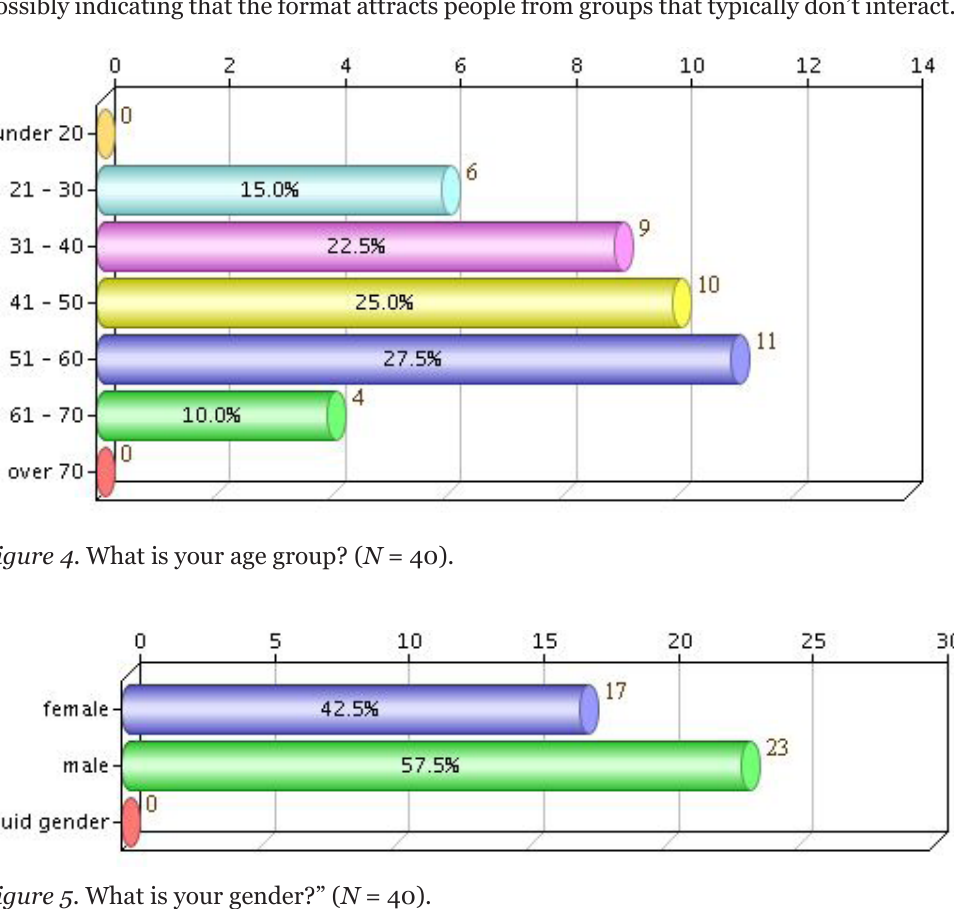
Figure 5 . What is your gender?” ( N = 40).